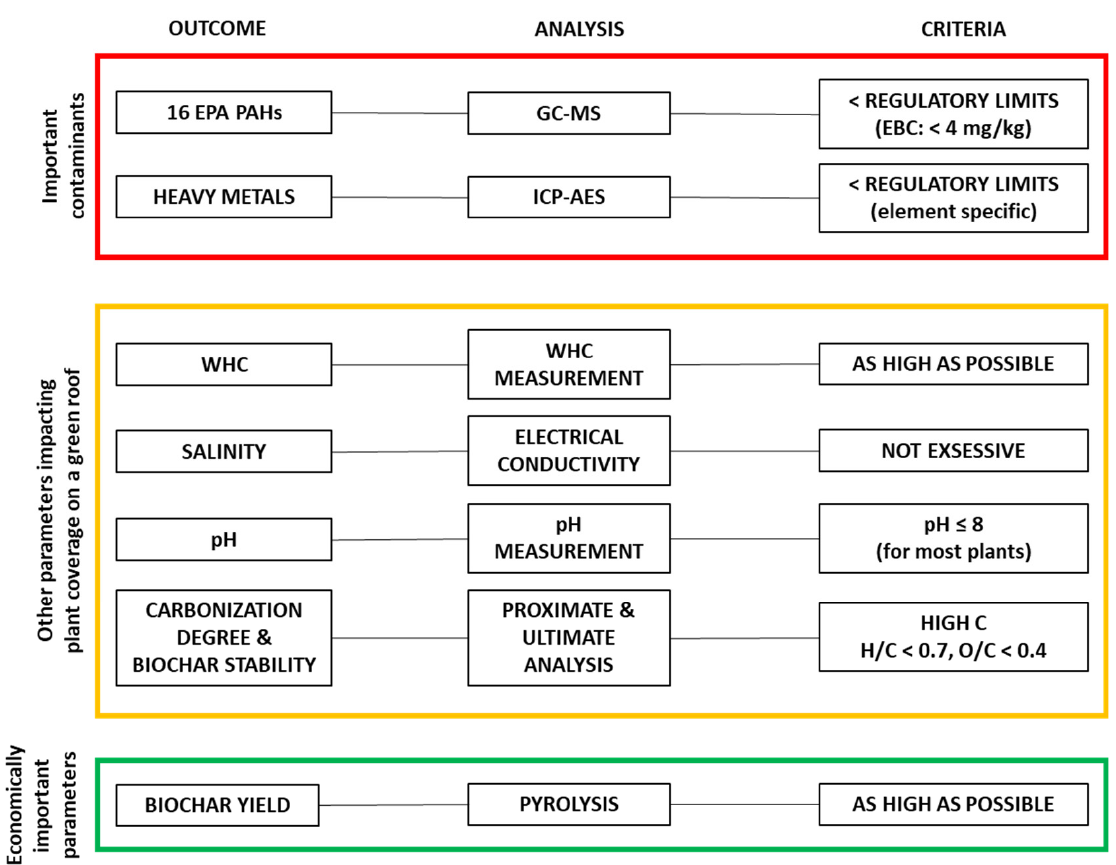
Figure 5. Selection procedure for the best performing biochar as amendment in green roof substrate. COF = coffee husks, MDF = medium-density fiberboard, PDF = palm date fronds, AB = AB wood waste, TB = tree bark, and OS = olive stones.